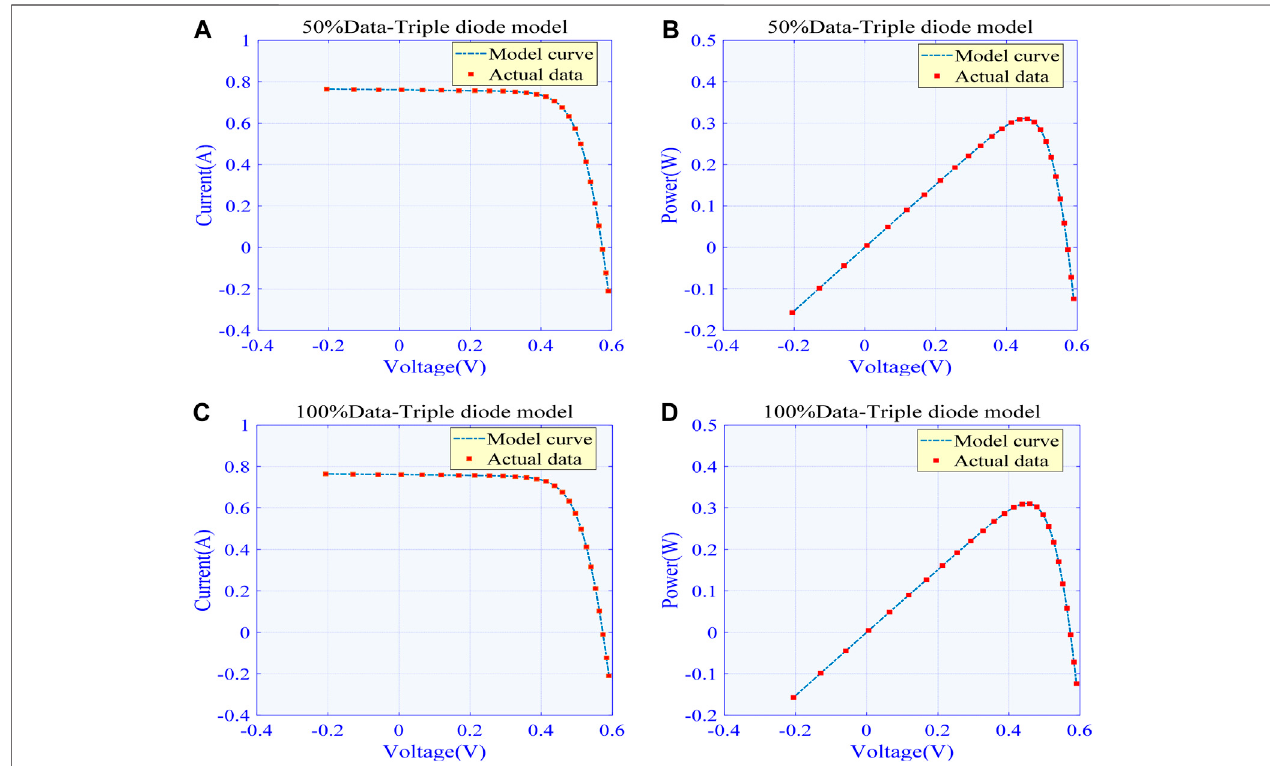
FIGURE13| Comparison between actualdata andmodel curve obtainedbythebestalgorithmindifferenttraining dataforTDM: (A) I-V curve in50%training data (B) P-V curve in 50% training data (C) I-V curve in 100% training data and (D) I-V curve in 100% training data.